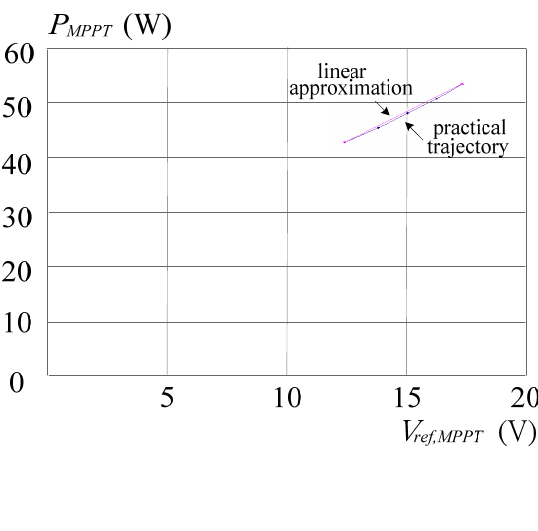
and V while module temperature increases MPPT ref,MPPT